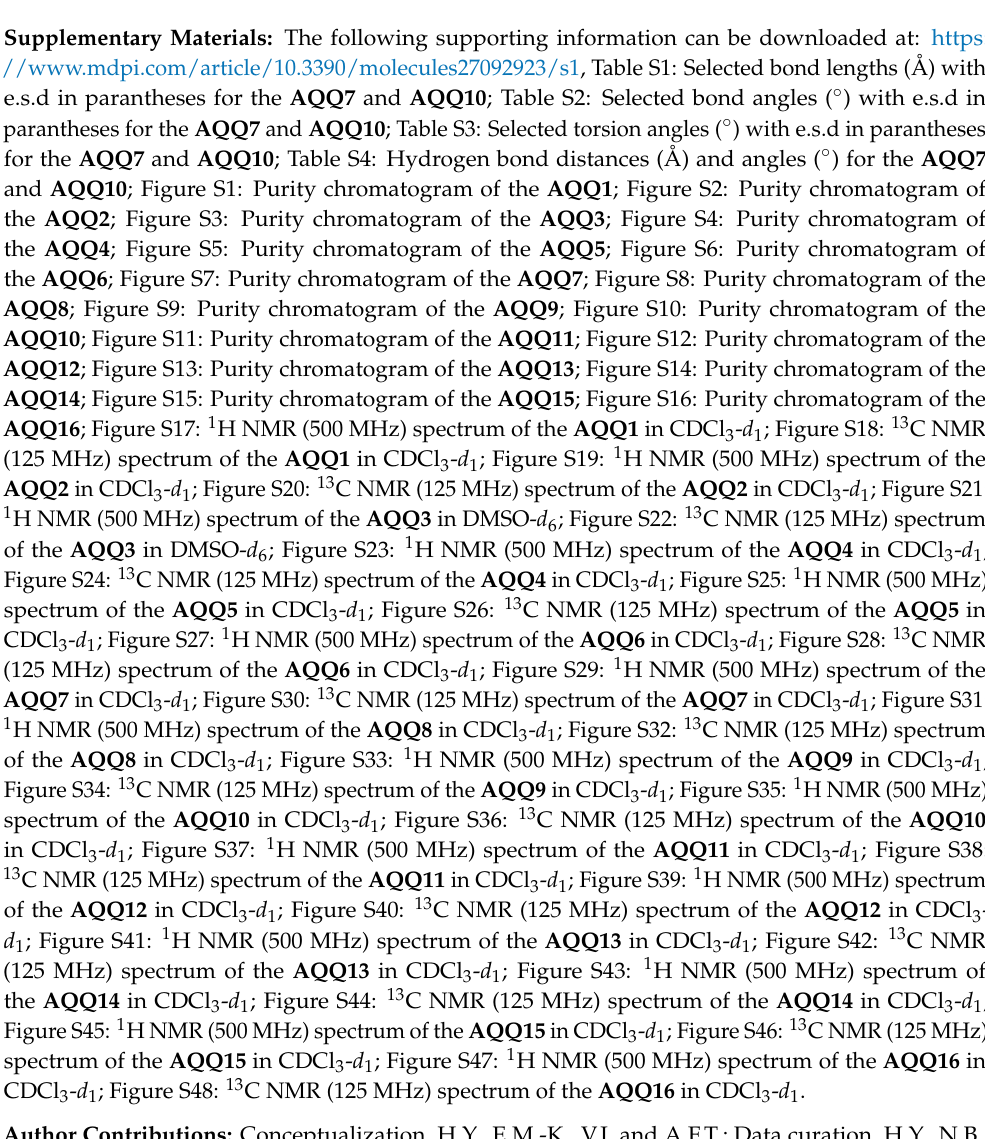
the AQQ4 ; Figure S5: Purity chromatogram of the AQQ5 ; Figure S6: Purity chromatogram of the AQQ6 ; Figure S7: Purity chromatogram of the AQQ7 ; Figure S8: Purity chromatogram of the AQQ8 ; Figure S9: Purity chromatogram of the AQQ9 ; Figure S10: Purity chromatogram of the AQQ10 ; Figure S11: Purity chromatogram of the AQQ11 ; Figure S12: Purity chromatogram of the AQQ12 ; Figure S13: Purity chromatogram of the AQQ13 ; Figure S14: Purity chromatogram of the AQQ14 ; Figure S15: Purity chromatogram of the AQQ15 ; Figure S16: Purity chromatogram of the AQQ16 ; Figure S17: 1 H NMR (500 MHz) spectrum of the AQQ1 in CDCl 3 - d 1 ; Figure S18: 13 C NMR (125 MHz) spectrum of the AQQ1 in CDCl 3 - d 1 ; Figure S19: 1 H NMR (500 MHz) spectrum of the AQQ2 in CDCl 3 - d 1 ; Figure S20: 13 C NMR (125 MHz) spectrum of the AQQ2 in CDCl 3 - d 1 ; Figure S21: 1 H NMR (500 MHz) spectrum of the AQQ3 in DMSO- d 13 C NMR (125 MHz) spectrum 6 ; Figure S22: of the AQQ3 in DMSO- d 6 ; Figure S23: 1 H NMR (500 MHz) spectrum of the AQQ4 in CDCl 3 - d 1 ; Figure S24: 13 C NMR (125 MHz) spectrum of the AQQ4 in CDCl 3 - d 1 ; Figure S25: 1 H NMR (500 MHz) spectrum of the AQQ5 in CDCl 3 - d 1 ; Figure S26: 13 C NMR (125 MHz) spectrum of the AQQ5 in CDCl 3 - d 1 ; Figure S27: 1 H NMR (500 MHz) spectrum of the AQQ6 in CDCl 3 - d 1 ; Figure S28: 13 C NMR (125 MHz) spectrum of the AQQ6 in CDCl 3 - d 1 ; Figure S29: 1 H NMR (500 MHz) spectrum of the AQQ7 in CDCl 3 - d 1 ; Figure S30: 13 C NMR (125 MHz) spectrum of the AQQ7 in CDCl 3 - d 1 ; Figure S31: 1 H NMR (500 MHz) spectrum of the AQQ8 in CDCl 13 C NMR (125 MHz) spectrum 3 - d 1 ; Figure S32: of the AQQ8 in CDCl 3 - d 1 ; Figure S33: 1 H NMR (500 MHz) spectrum of the AQQ9 in CDCl 3 - d 1 ; Figure S34: 13 C NMR (125 MHz) spectrum of the AQQ9 in CDCl 3 - d 1 ; Figure S35: 1 H NMR (500 MHz) spectrum of the AQQ10 in CDCl 3 - d 1 ; Figure S36: 13 C NMR (125 MHz) spectrum of the AQQ10 in CDCl 3 - d 1 ; Figure S37: 1 H NMR (500 MHz) spectrum of the AQQ11 in CDCl 3 - d 1 ; Figure S38: 13 C NMR (125 MHz) spectrum of the AQQ11 in CDCl 1 H NMR (500 MHz) spectrum 3 - d 1 ; Figure S39: of the AQQ12 in CDCl 3 - d 1 ; Figure S40: 13 C NMR (125 MHz) spectrum of the AQQ12 in CDCl 3 - d 1 ; Figure S41: 1 H NMR (500 MHz) spectrum of the AQQ13 in CDCl 3 - d 1 ; Figure S42: 13 C NMR (125 MHz) spectrum of the AQQ13 in CDCl 3 - d 1 ; Figure S43: 1 H NMR (500 MHz) spectrum of the AQQ14 in CDCl 3 - d 1 ; Figure S44: 13 C NMR (125 MHz) spectrum of the AQQ14 in CDCl 3 - d 1 ; Figure S45: 1 H NMR (500 MHz) spectrum of the AQQ15 in CDCl 3 - d 1 ; Figure S46: 13 C NMR (125 MHz) spectrum of the AQQ15 in CDCl 3 - d 1 ; Figure S47: 1 H NMR (500 MHz) spectrum of the AQQ16 in CDCl 3 - d 1 ; Figure S48: 13 C NMR (125 MHz) spectrum of the AQQ16 in CDCl 3 - d 1